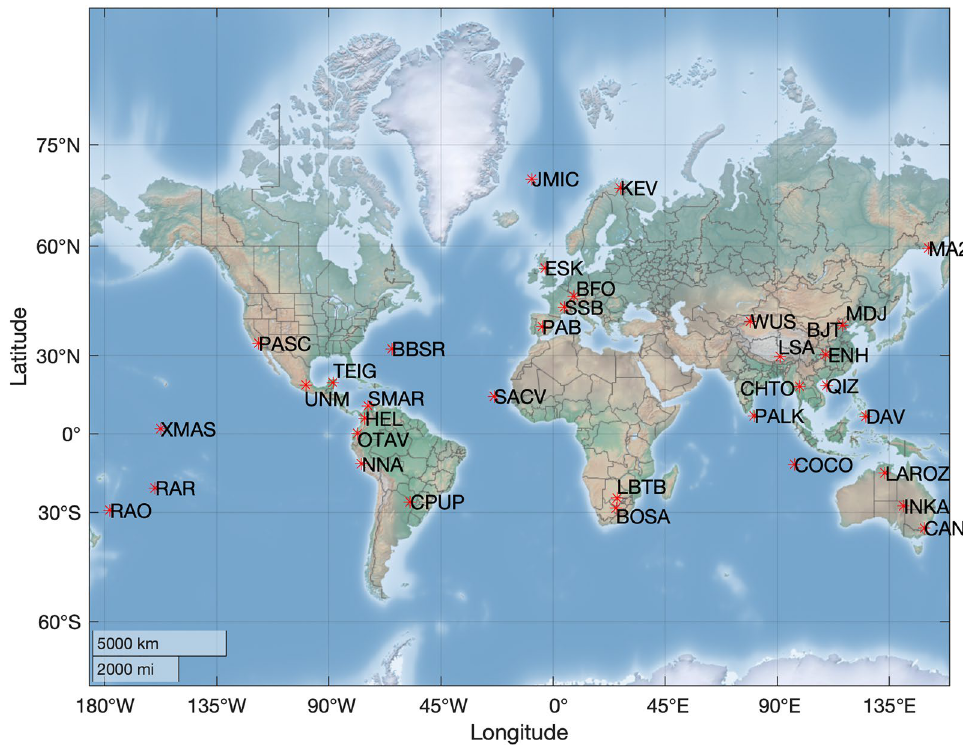
Figure 1. Locations across the world where anthropogenic noise reduction is observed during January to early May 2020. Matlab version 2020a was used to make this map (https:// matlab. mathw orks.